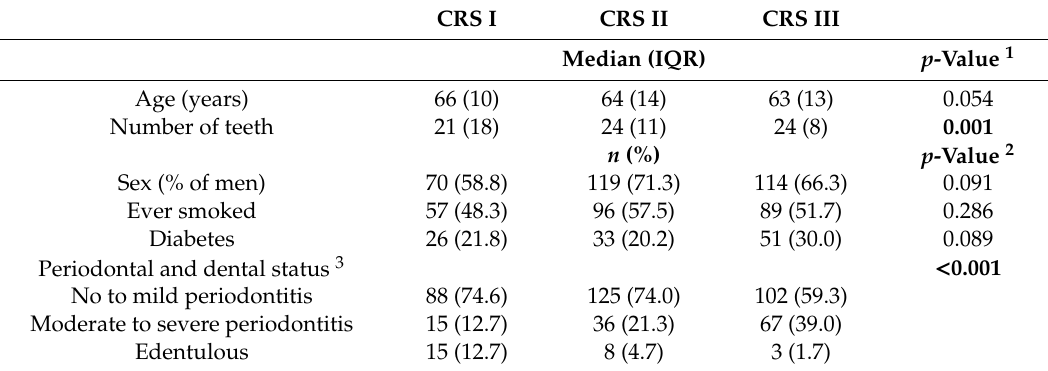
Table 1. Characteristics of the study population divided into three groups on the basis of cumulative risk score (CRS)